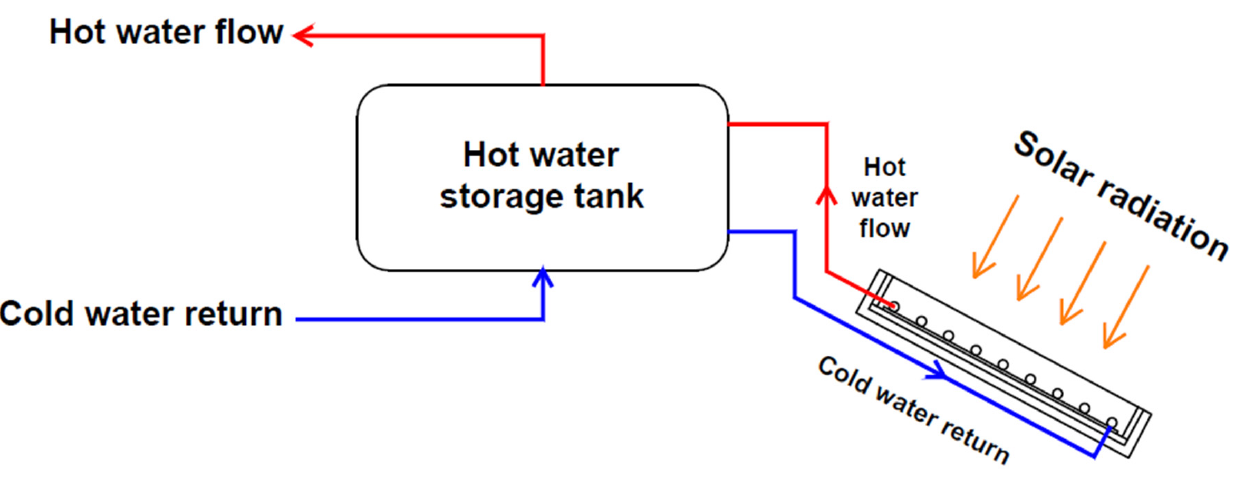
Figure 4. The working principle of an FPC solar water heater with a passive (thermosyphon), compact system [56].